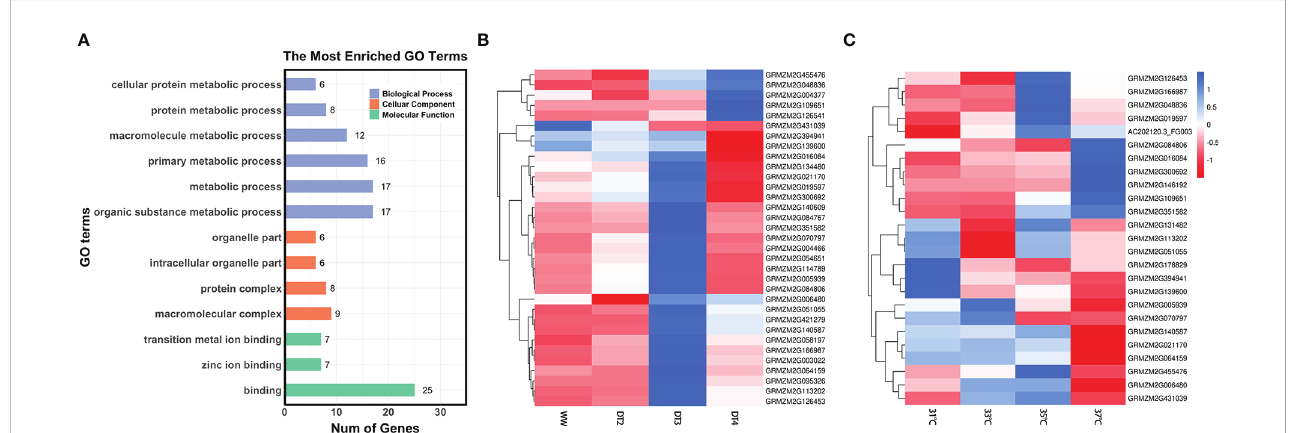
FIGURE 4 (A) Results of gene ontology-based functional enrichment analysis. (B) Clustered heatmap of expression values for 33 genes under different drought level treatments. WW stands for well-watered condition, DT2, DT3, and DT4 represent soil moistures for maize plants were 30-35%, 20-25%, and 10-15%, respectively. (C) Clustered heatmap of expression values for 25 genes under different temperature treatments (31°C, 33°C, 35°C, and 37°C). The numerical data represent the Z-score of mean TPM of two or three